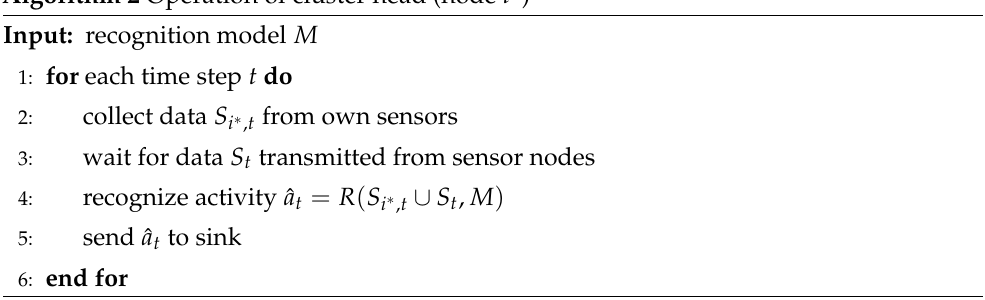
Algorithm 2 Operation of cluster head (node i ∗